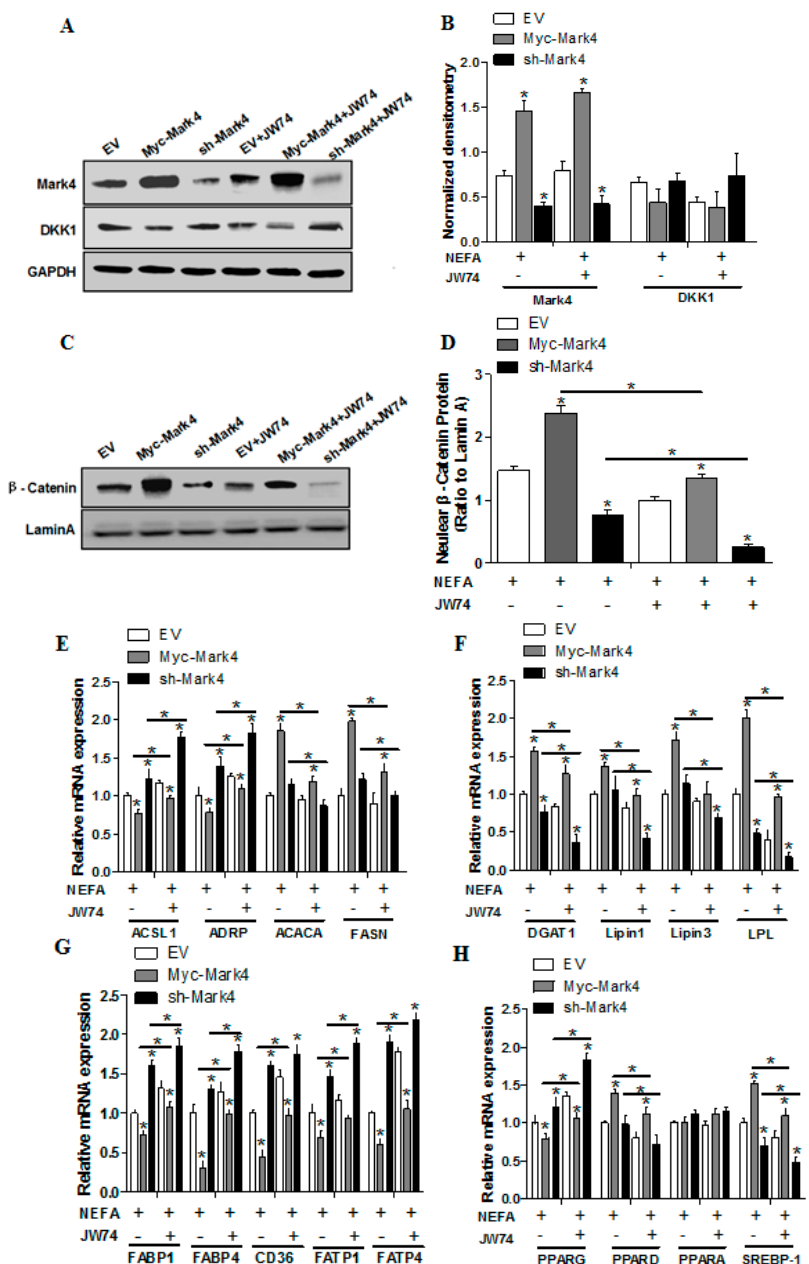
Figure 7. Activation of the WNT/ β -catenin pathway by MARK4 promotes lipogenesis in pig primary trophoblast cells challenged with 400 μ M NEFA. ( A – D ) Representative immunoblots and densitometric quantification for MARK4, DKK1 and β -catenin after transfection with Myc-MARK4, sh-MARK4 for 48 h in primary trophoblast cells isolated from pig placentas. Cells were then incubated with 400 μ M NEFA or 10 μ M JW74 for 24 h ( n = 3). ( E – H ) Relative mRNA expression of lipid metabolism-related genes ( E and F ), fatty acid (FA) transporters ( G ) and regulators of lipid metabolism ( H ) after transfection with Myc-MARK4, sh-MARK4 for 48 h in primary trophoblast cells. Cells were then treated with 400 μ M NEFA or 10 μ M JW74 for 24 h ( n = 3). Values are expressed as mean ± SEM.* p < 0.05 compared with the control group. Myc-MARK4 group: over expression of MARK4 group, sh-MARK4 group: knock down of MARK4 group, Control: empty vector (EV) group.